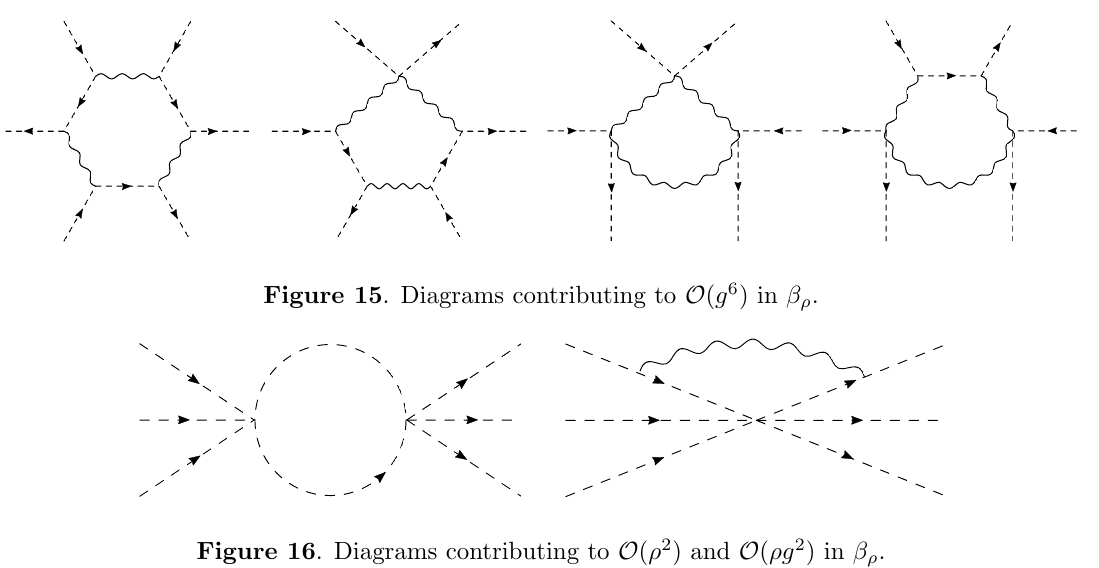
Figure 16 . Diagrams contributing to